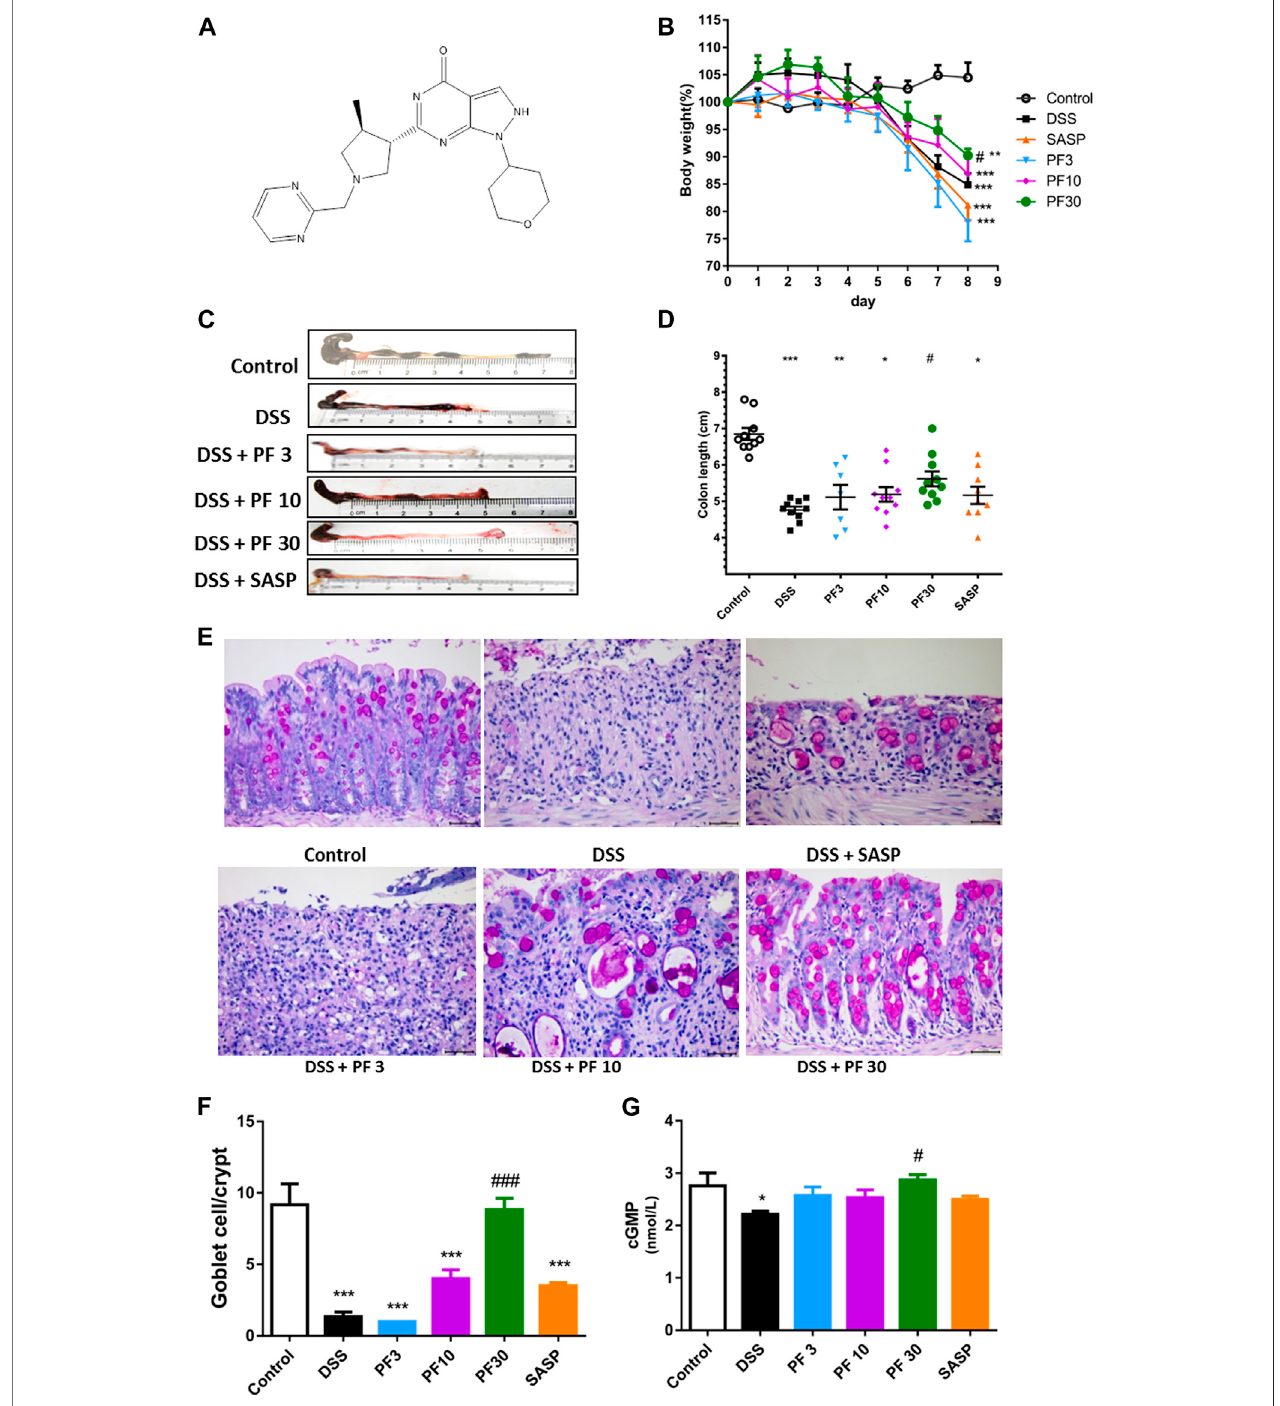
FIGURE 1 | Effect of PF-04447943 on DSS-induced colitis model. Mice were randomly divided into six groups as described in the material and methods section. Controlmicereceiveddeionizedwater,DSS-treatedmicereceived(3%DSSindeionizedwater),co-treatmentmicereceivedPF-04447943 at3,10,and30 mg/kgbody weight, and sulfasalazine (SASP) at 0.5 gm/kg for 7 days. (A) Structure of PF-04447943 drawn by using ChemDraw 15. (B) Bodyweight of mice was measured in each group ( n (cid:1) 10). (C) Microscopic presentation of the colon from each group. (D) Quanti fi cation of colon length in each group ( n (cid:1) 10). (E) Representation of goblet cellsinthecolonbyPASstaining. (F) Quanti fi cationofgobletcellspercrypt. (G) Quanti fi cationofcGMPlevelinthecolonofmicefromeachgroup.Dataarepresentedas mean ± standard error mean (SEM) ( n (cid:1) 10). Here, *** p < 0.001, ** p < 0.01, * p < 0.05 vs. control group and ### p < 0.001, ## p < 0.01, # p < 0.05 vs. DSS-treated group.